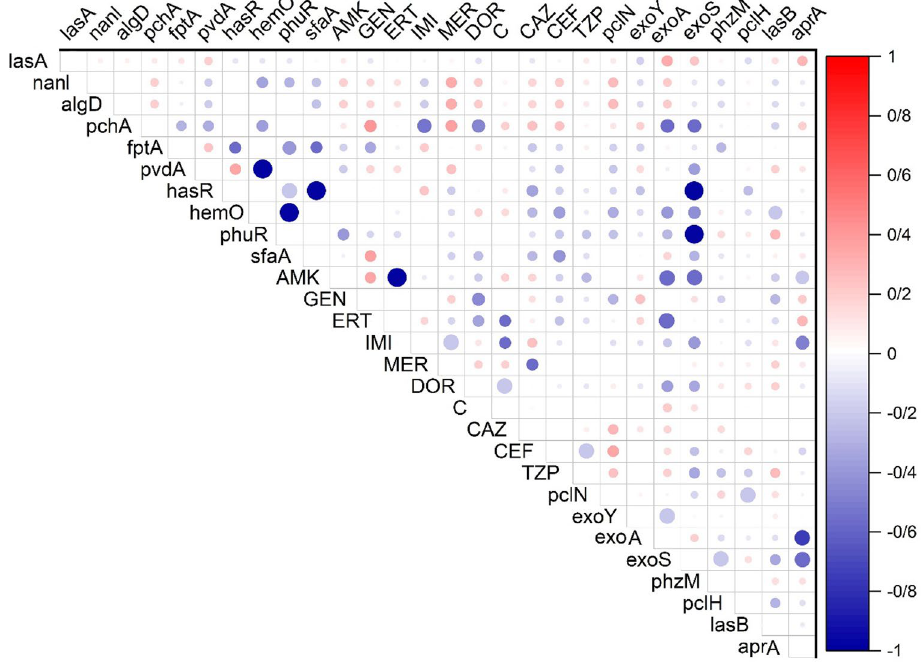
Figure 4 . Correlation matrix of phenotypical (antibiotic resistance profile) and genotypical (virulence factor profile and iron/siderophore activity) characteristics with significant correlations (p < 0.05). There is no significant correlation between white spaces. The blue circles indicated a significant positive relationship, and the red indicated a significant negative relationship. The size and strength of color represent the numerical value of the Phi correlation